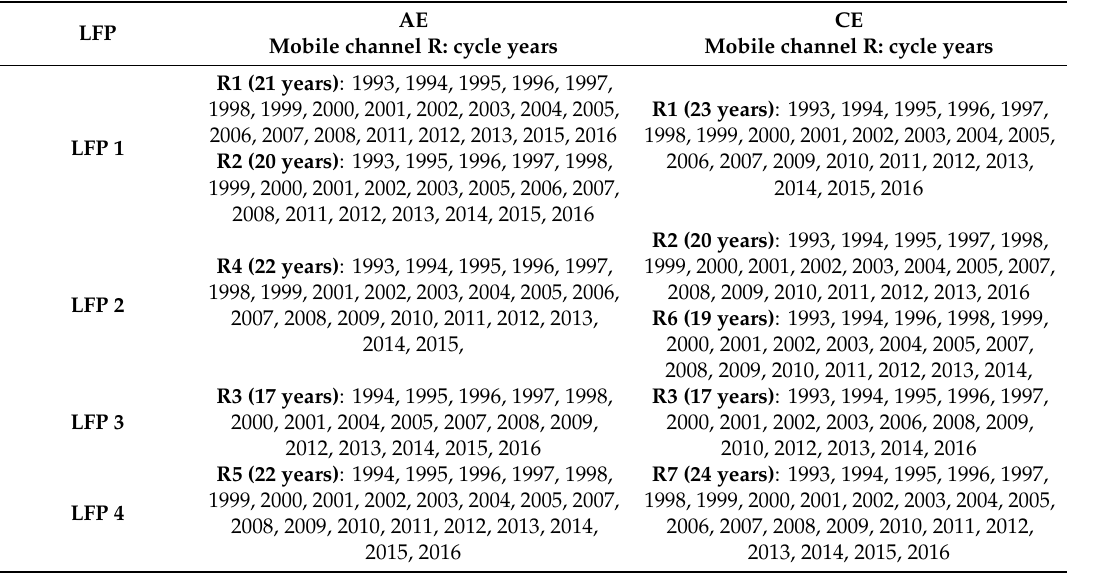
Table 2. The AE and CE LFPs show an annual periodic pattern LFPs in the seven migration channels. AE LFP Mobile channel R: cycle years